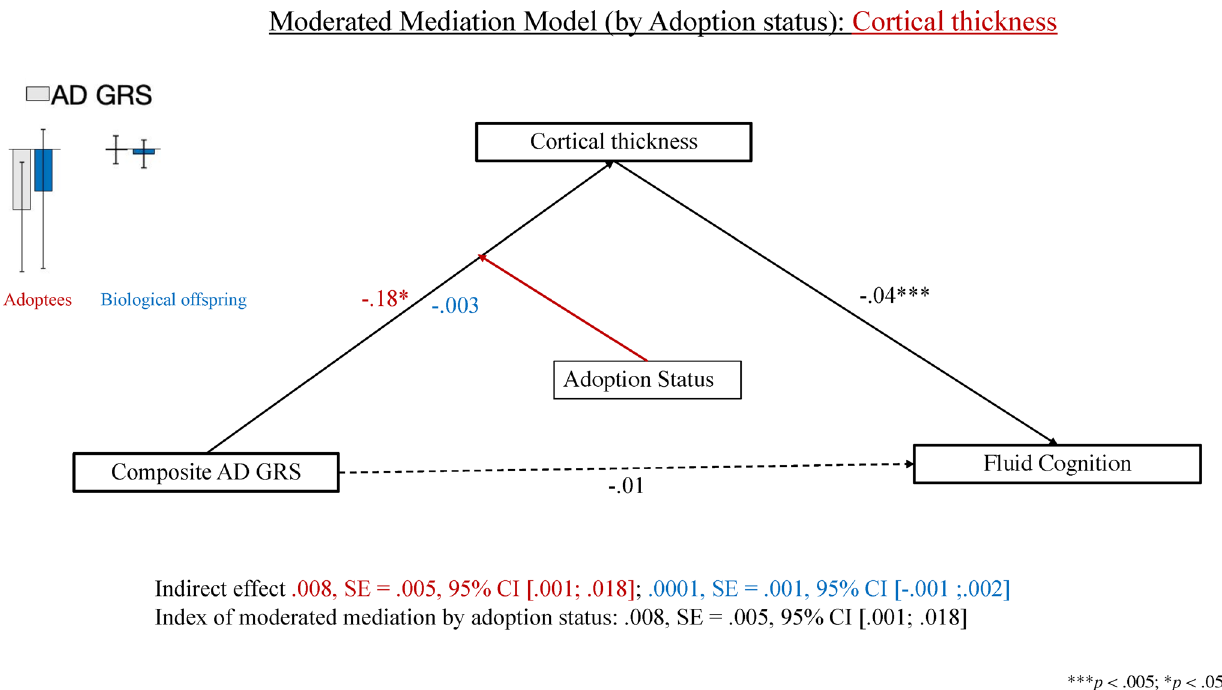
Figure 3. Results of the moderated mediation analysis comparing the effect of the composite AD GRS on fluid cognition via cortical thickness among adoptees and non-adoptees. AD Alzheimer’s Disease, GRS genetic risk score. Coefficients in red font describe the adoptees, those in blue font, the biological offspring, whereas those in black font apply to the full sample.